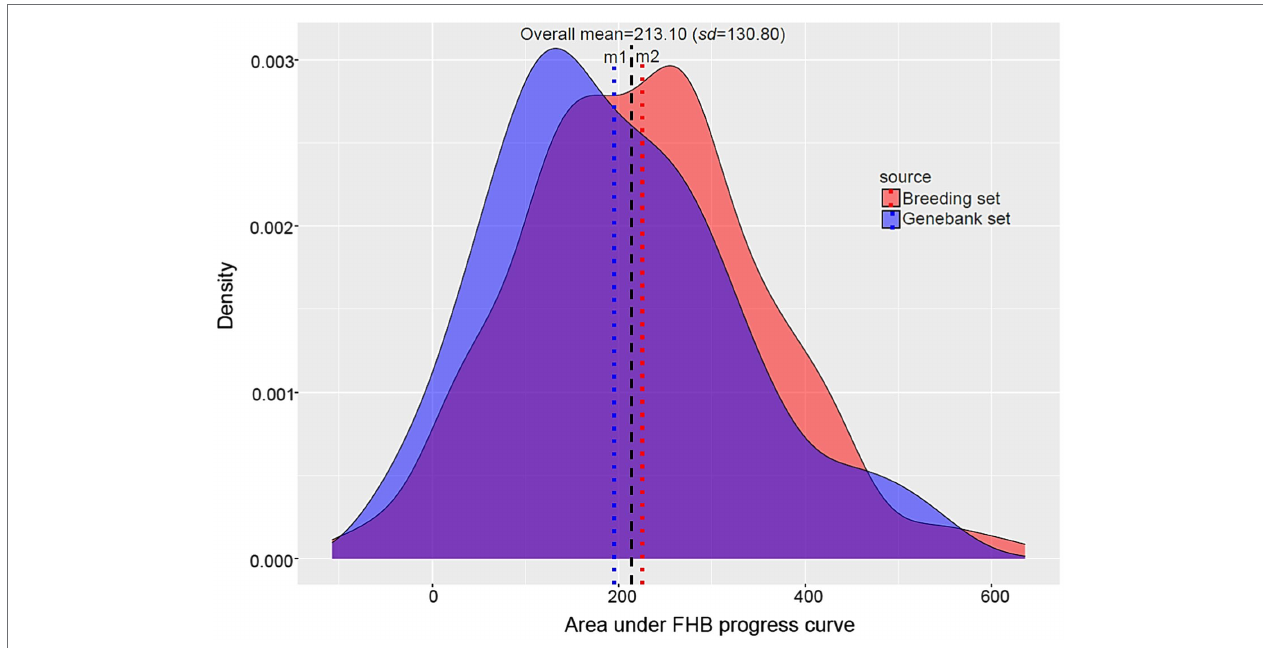
FIGURE 5 | Histogram of the area under disease progress curve (AUDPC) for FHB in the wheat genotypes collected from two sources. m1 and m2 represent the mean AUDPC for FHB in genebank set and breeding set,